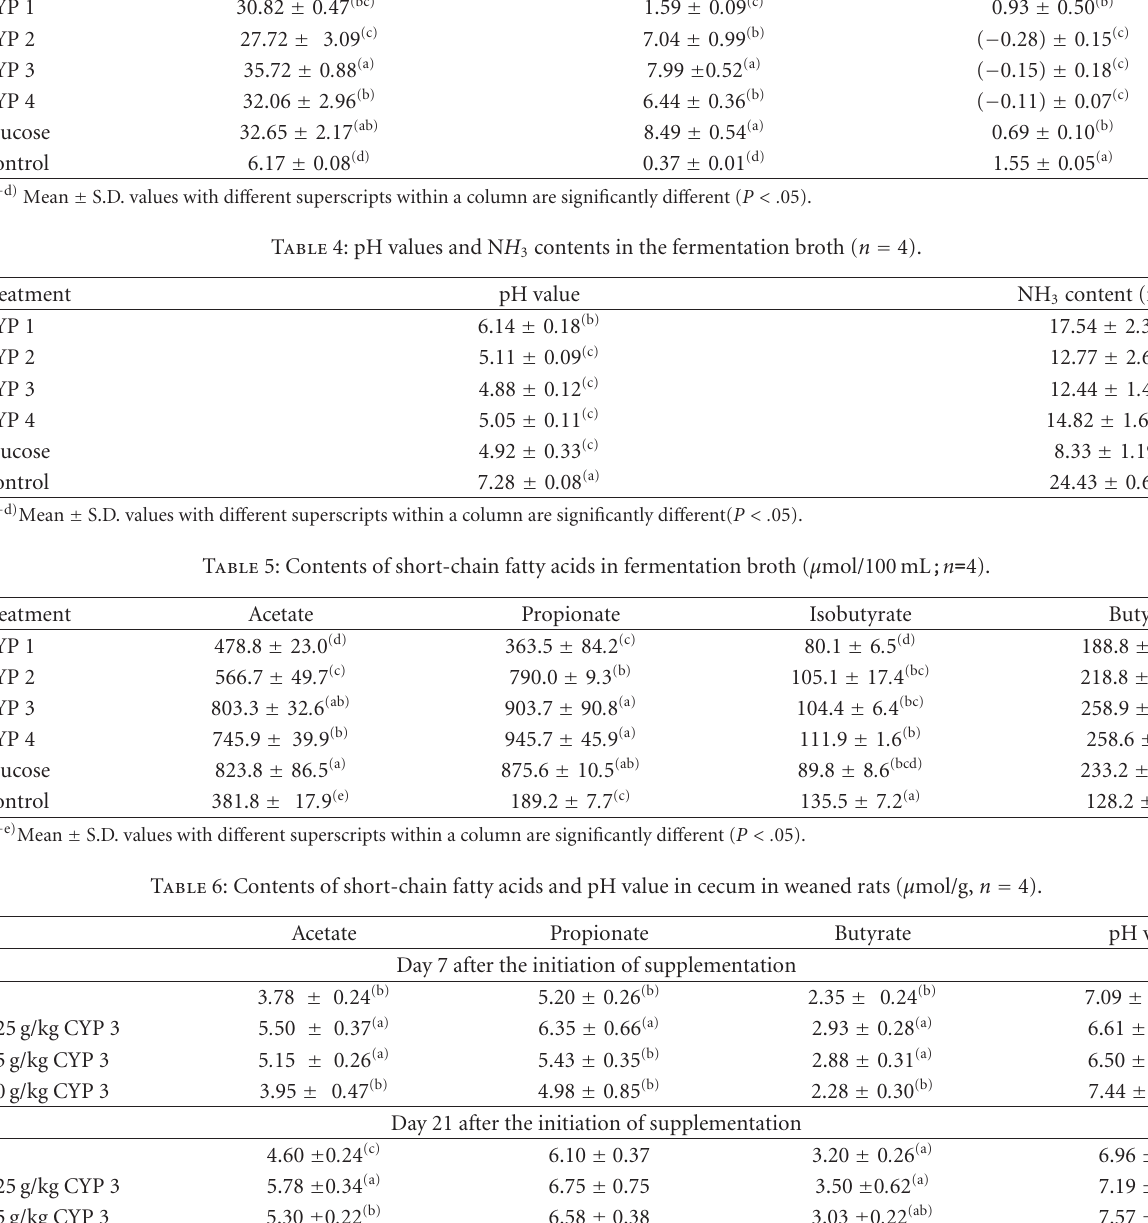
Table 3: In vitro gas production parameters with Chinese Yam polysaccharide (CYP) and glucose ( n = 4). Treatment